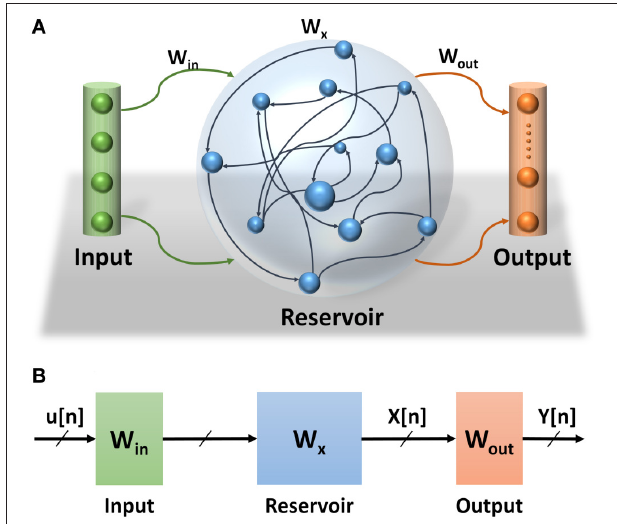
FIGURE 1 | (A) Echo State Network consists of three layers: input layer, reservoir layer, and output layer. (B) Echo State Network abstract structure. How signals propagate through the ESN and the effects of different weight sets in the